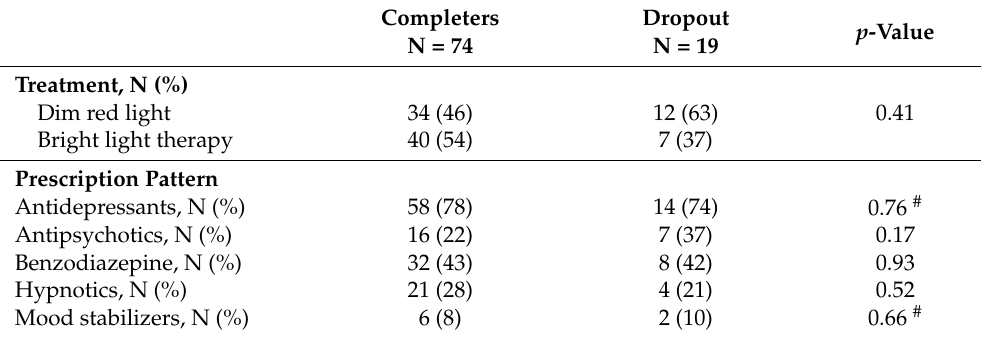
Table 2. Light treatment allocation and the prescription of psychotropic medications for the Dropout and Completer